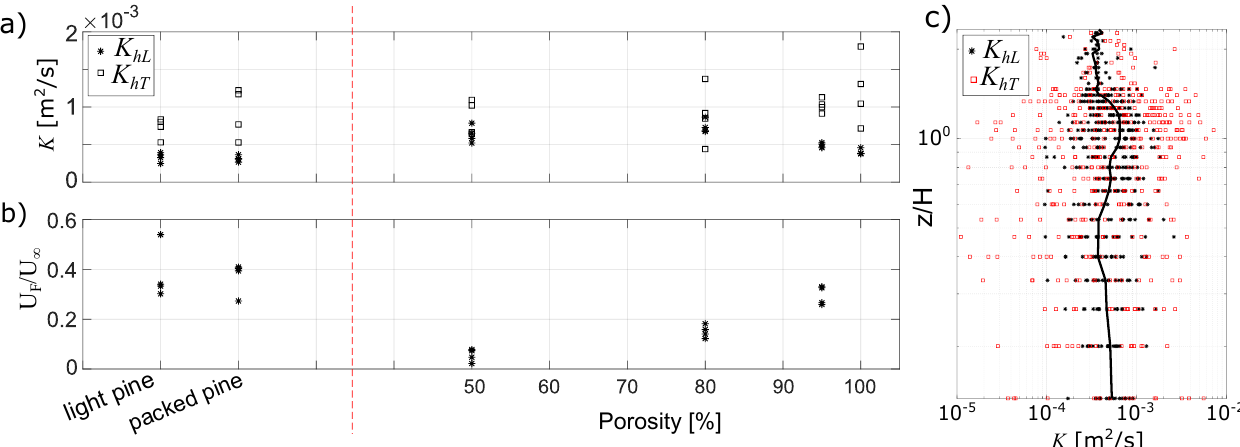
Figure 4. ( a ) Averaged lateral eddy diffusivity K h within the fuel layer ( z / H < 1) computed following (2) and (3). All data are shown (4 data points for each porosity, two background speeds, and two locations within the wind tunnel; some points overlap). Porosity of 100% corresponds to the empty wind tunnel. ( b ) The ratio of the averaged streamwise velocity within the fuel layer U F ( z / H < 1) and the background velocity U ∞ . ( c ) Vertical profile of the lateral diffusivity estimated for all observations following (2) (black stars) and (3) (red